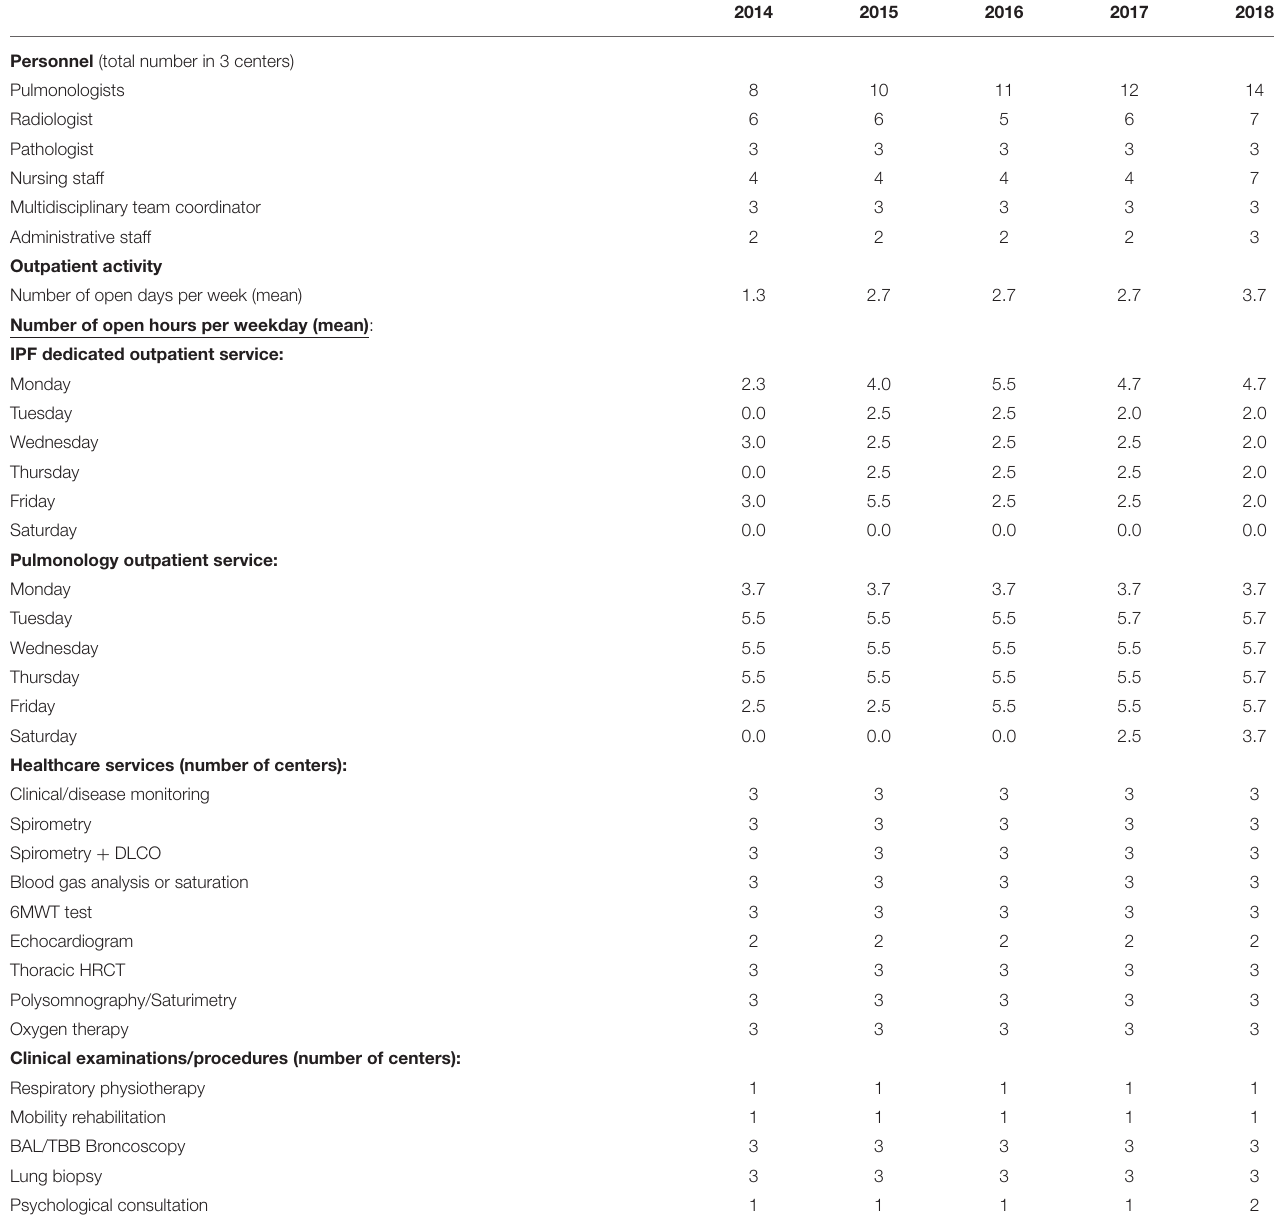
TABLE 2 | IPF Centers: available resources and services